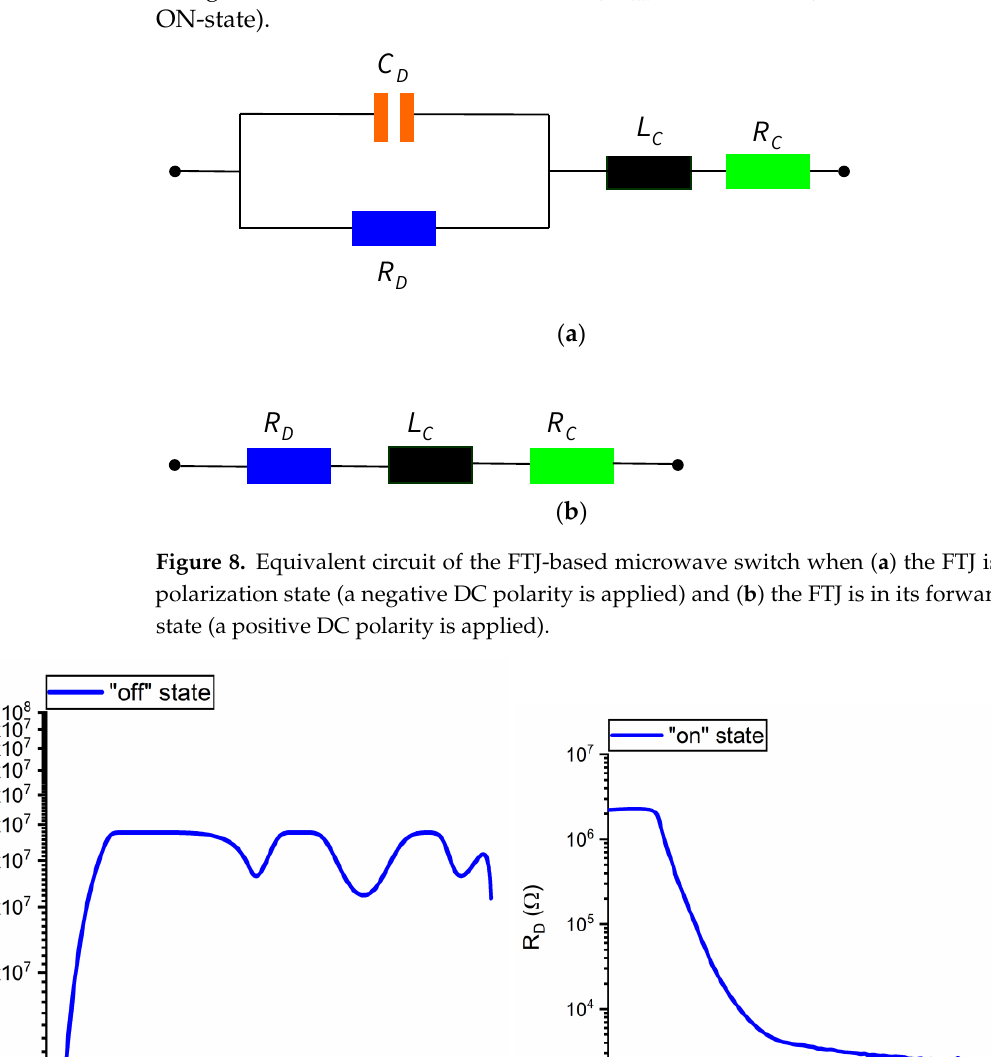
Figure 9. Dependence of the differential resistance R D on the applied DC voltage for the ( a ) OFF-and ( b ) ON-state of the DC switch.